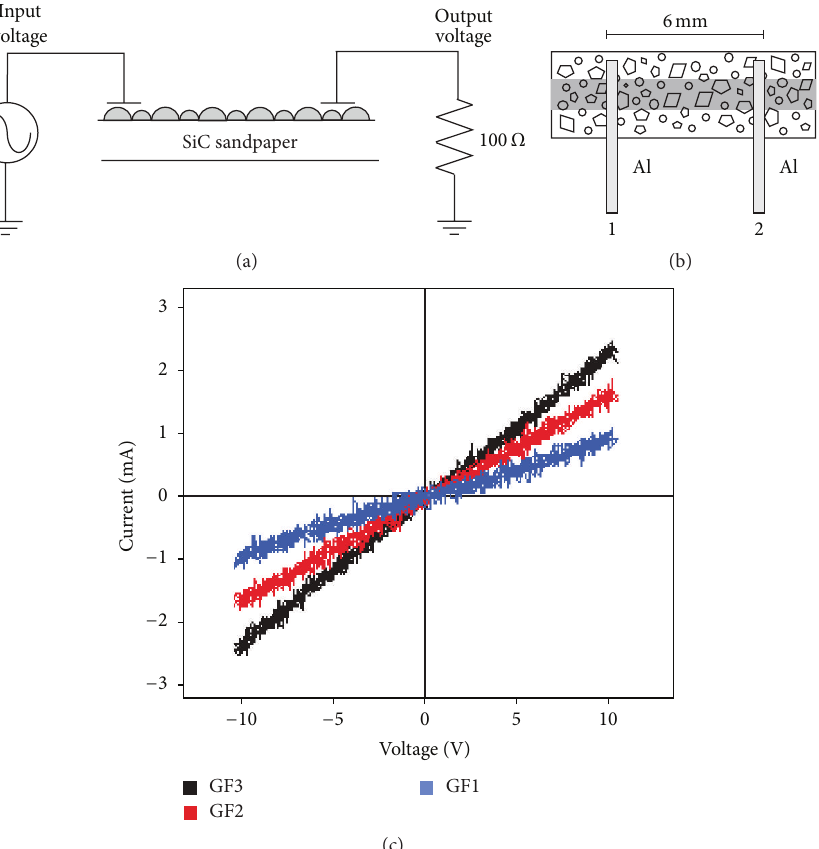
Figure 4: (a) Practical circuit implemented. (b) Physical diagram of the experimental procedure. (c) Current-voltage